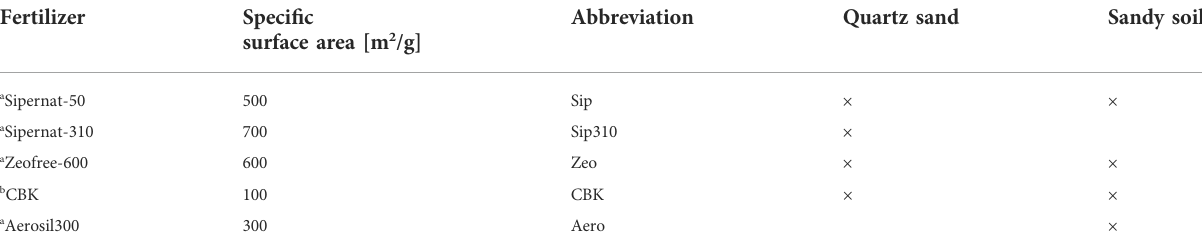
TABLE 1 List of the selected arti fi cial Si amendments used in this study. These amendments were mixed with pure quartz sand and sandy soil.